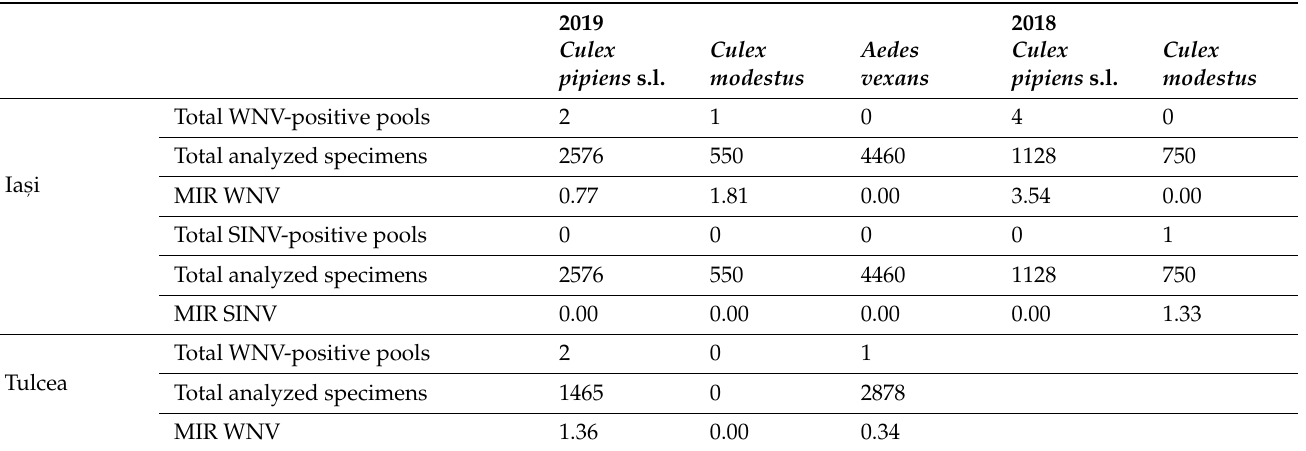
Table 2. MIR by WNV for Culex pipiens s.l., Culex modestus and Aedes vexans mosquitoes, per time period (2018 or 2019) and county (Ias i or ,